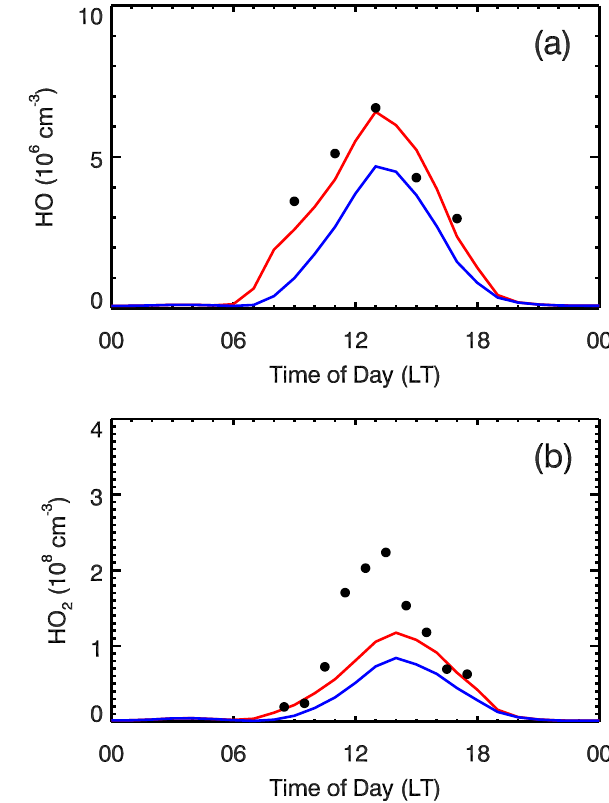
Fig. 6. Influence of the HONO sources on the (a) HO and (b) HO 2 diurnal cycle at T0 averaged during the 24–29 March 2006. The black dots correspond to the observations, and the solid red and blue lines are the simulations in the E-case and H-case,